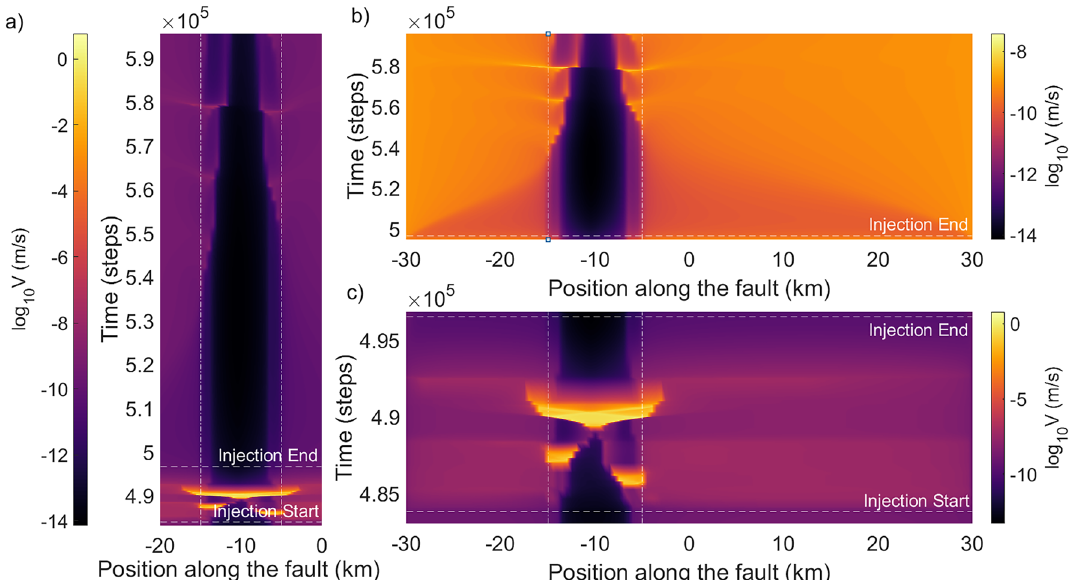
Figure 2. Seismic and aseismic slip response of the fault under pore-pressure perturbation. ( a – c ) log 10 Sliprate in m/s (color scale) versus position along the fault versus time steps. Plots present results from a simulation with P max = 1.45 MPa. Horizontal dashed lines indicate the injection start and end times. Vertical dashed lines demarcate the VW region of the fault. ( a ) Perturbation duration as well as the subsequent quiet period. ( b ) Zoomed-in figure of the interseismic period—all the slip seen in this plot is aseismic. The plot starts at the end of the injection and ends before the beginning of the next earthquake in the cycle. ( c ) Zoomed-in figure of the period under perturbation—seismic events are bright yellow in colour. Note that the color scale in ( b ) shows a narrower range of slip rate in order to highlight the aseismic transients during the interseismic